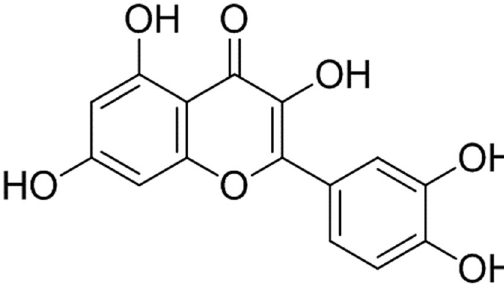
Figure 1. The chemical structure of